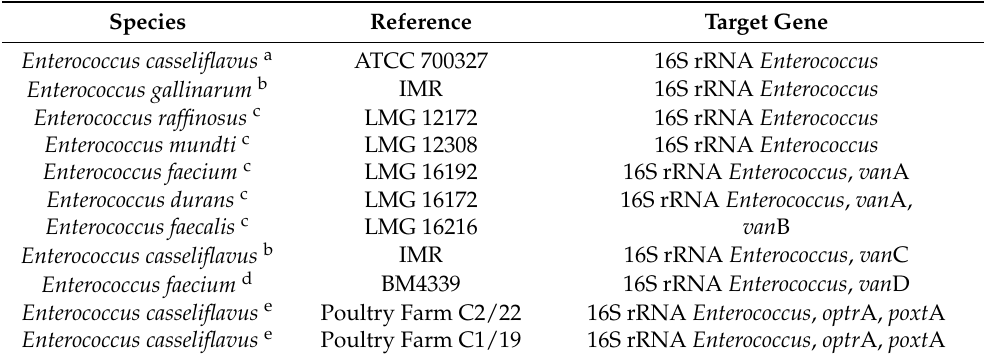
Table 1. Reference strains utilized for the sensitivity evaluation of multiplex and monoplex PCR assays.